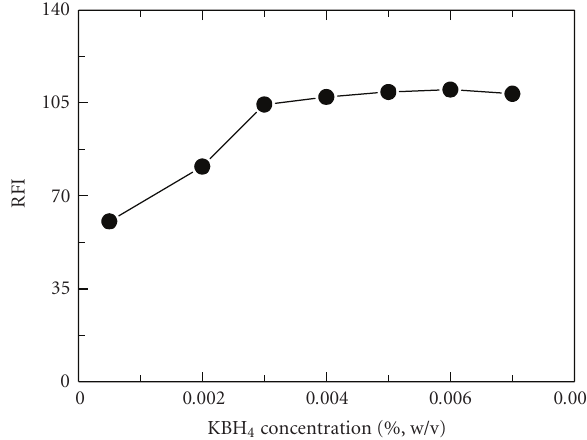
Figure 4: E ff ect of KBH 4 concentration on the fluorescence intensity of the reaction product of AMD (1 μ g mL − 1 ) with NQS (0.06%, w/v).